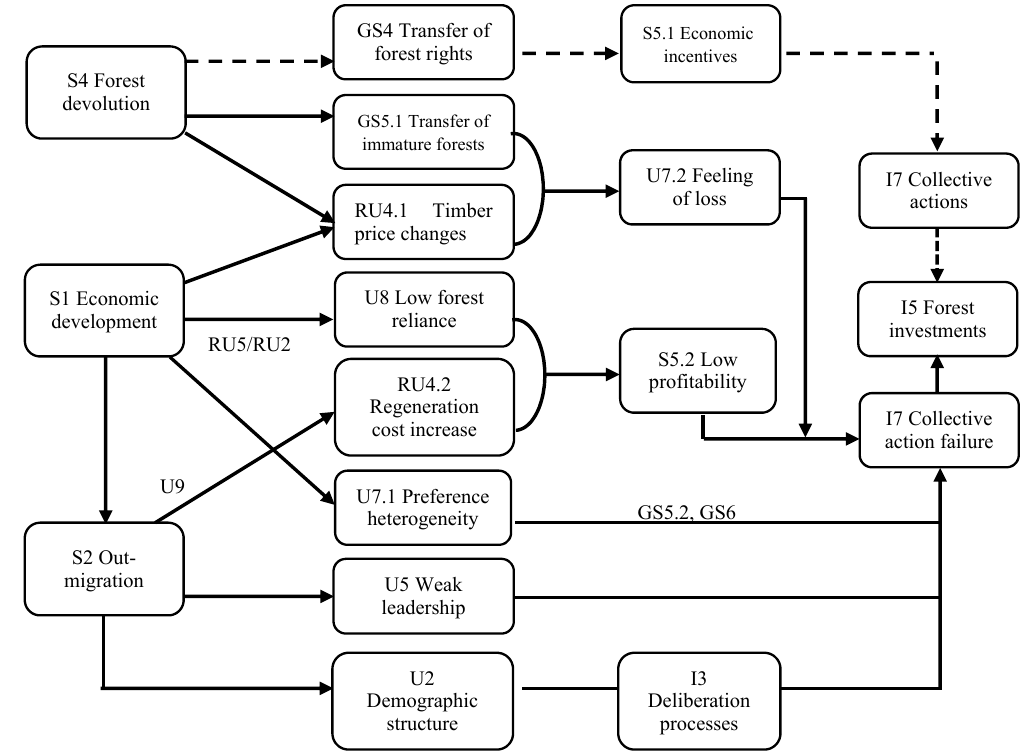
Figure 7. Relationships between forest devolution, socio-economic changes, and forest management outcomes after the reform. Note: The solid line shows the counteracting effects of forest devolution on forest investments, while the dashed line shows the expected positive effect of forest devolution. RU5, RU2, U9, GS5.2, and GS6 are moderating factors. RU5: small per capita forestland holdings. RU2: long rotation of Chinese fir. U9: high labor intensity of timber production operations. GS5.2: equal-per capita benefit-sharing rule. GS6: unanimous consent decision-making